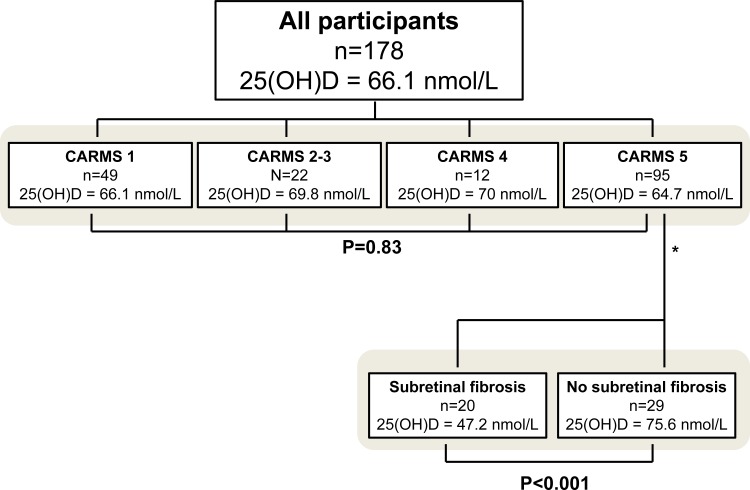
Number of participants and mean plasma 25-hydroxyvitamin D, 25(OH)D in subgroups of age-related macular degeneration.Participants were categorized into subgroups after a thorough retinal examination. Please note that when comparing vitamin D status in patients in CARMS 5 with or without subretinal fibrosis, 46 previously treated patients with neovascular AMD were excluded from analysis (denoted by asterix).